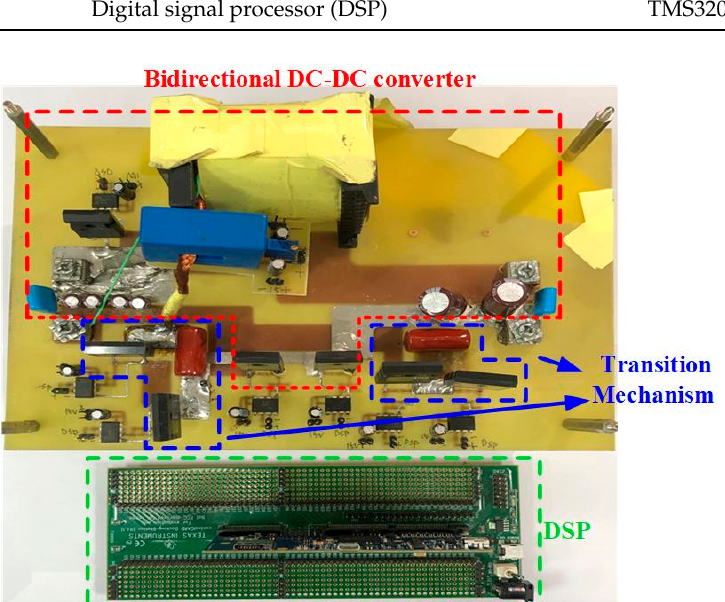
Figure 18. Image of the example experimental